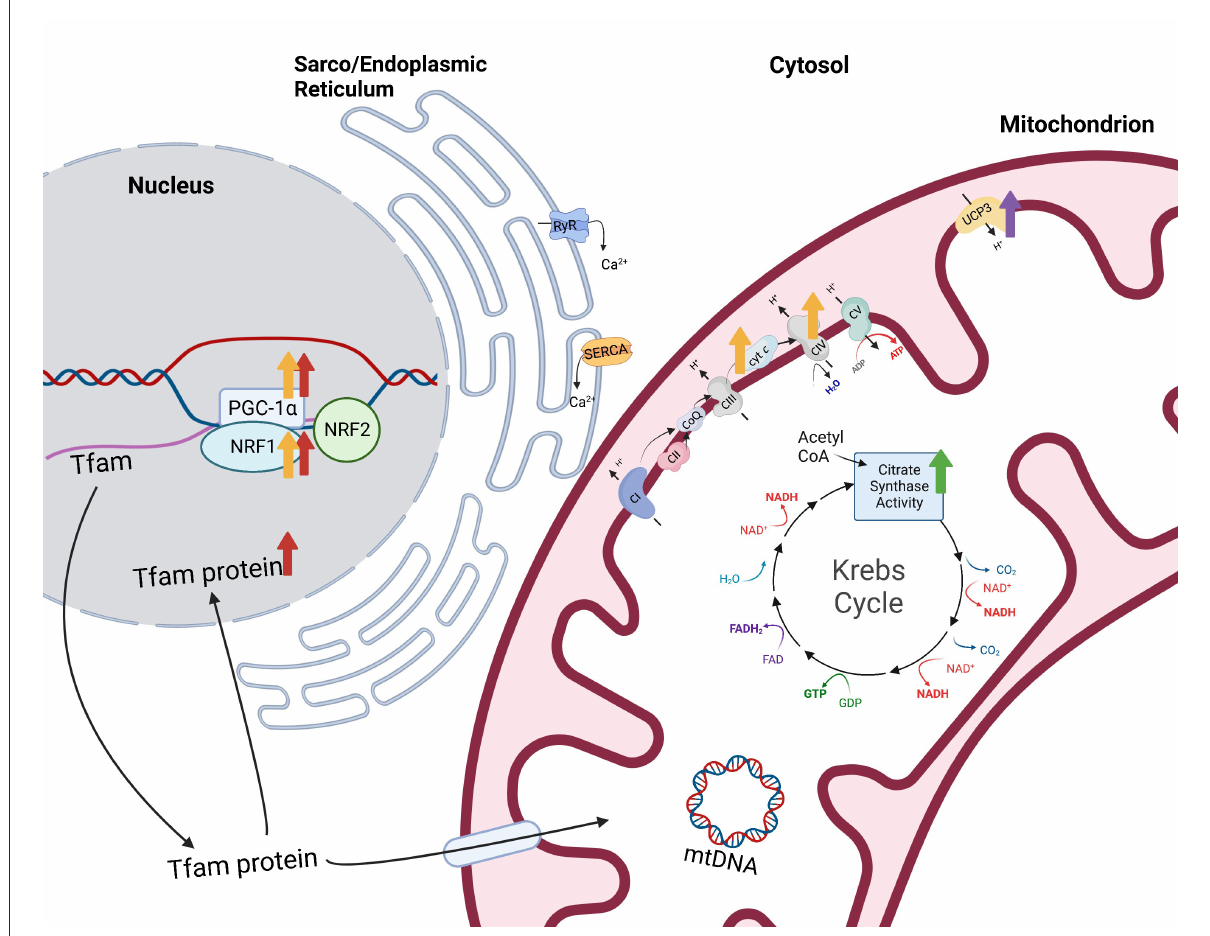
FIGURE2 Impacts of selenium supplementation or treatment on mitochondrial function. Citrate synthase activity, a measurement of mitochondrial volume density, is greater (green arrow) in the gluteus medius muscle of horses supplemented 0.3mg Se/kg DM (9). Additionally, overexpression of the selenoprotein H ( SELENOH ) gene in murine hippocampal HT22 neuronal cells resulted in greater levels of mitochondrial biogenesis regulators proliferator-activated receptor- γ coactivator-1 alpha (PGC-1 α ) and nuclear respiratory factor 1 (NRF1) and mitochondrial transcription factor A (Tfam) within the nuclear fraction [red arrows (10)]. Similarly, sodium selenite-treated HT22 neuronal cells also had greater PGC-1 α and NRF1 and greater mitochondrial proteins, cytochrome c and cytochrome c oxidase IV [yellow arrows (11)]. Finally, type 2 deiodinase (D2) induction in C2C12 cells resulted in increased expression of mitochondrial uncoupling protein 3 [ UCP3 (12)]. Created with